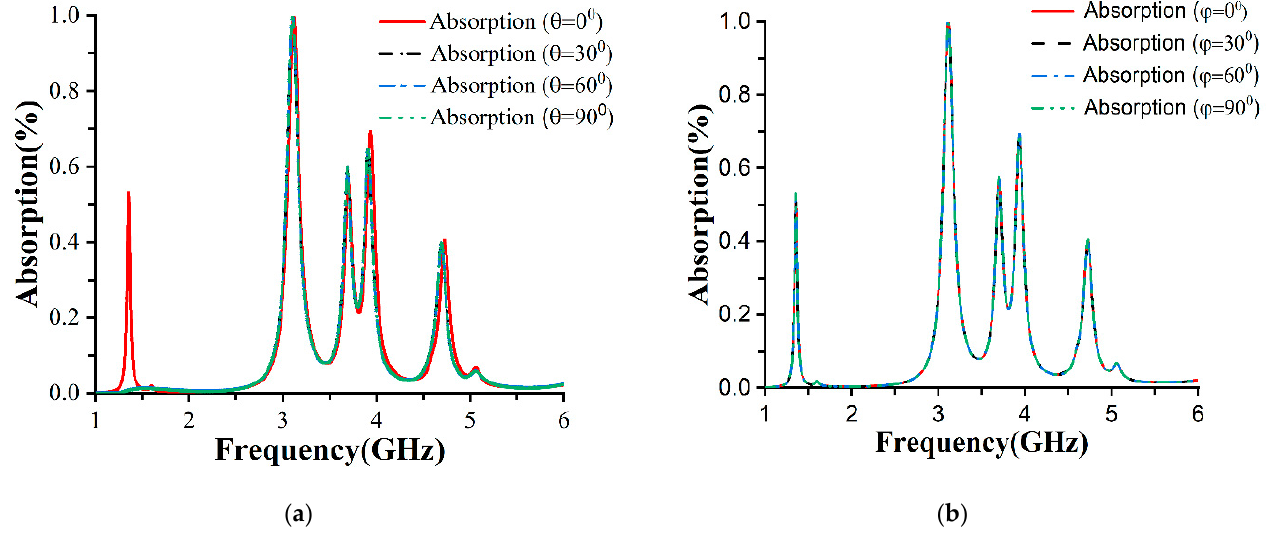
Figure 9. Absorption rate of FR-4 for different polarization angles ( a ) θ and ( b ) φ .